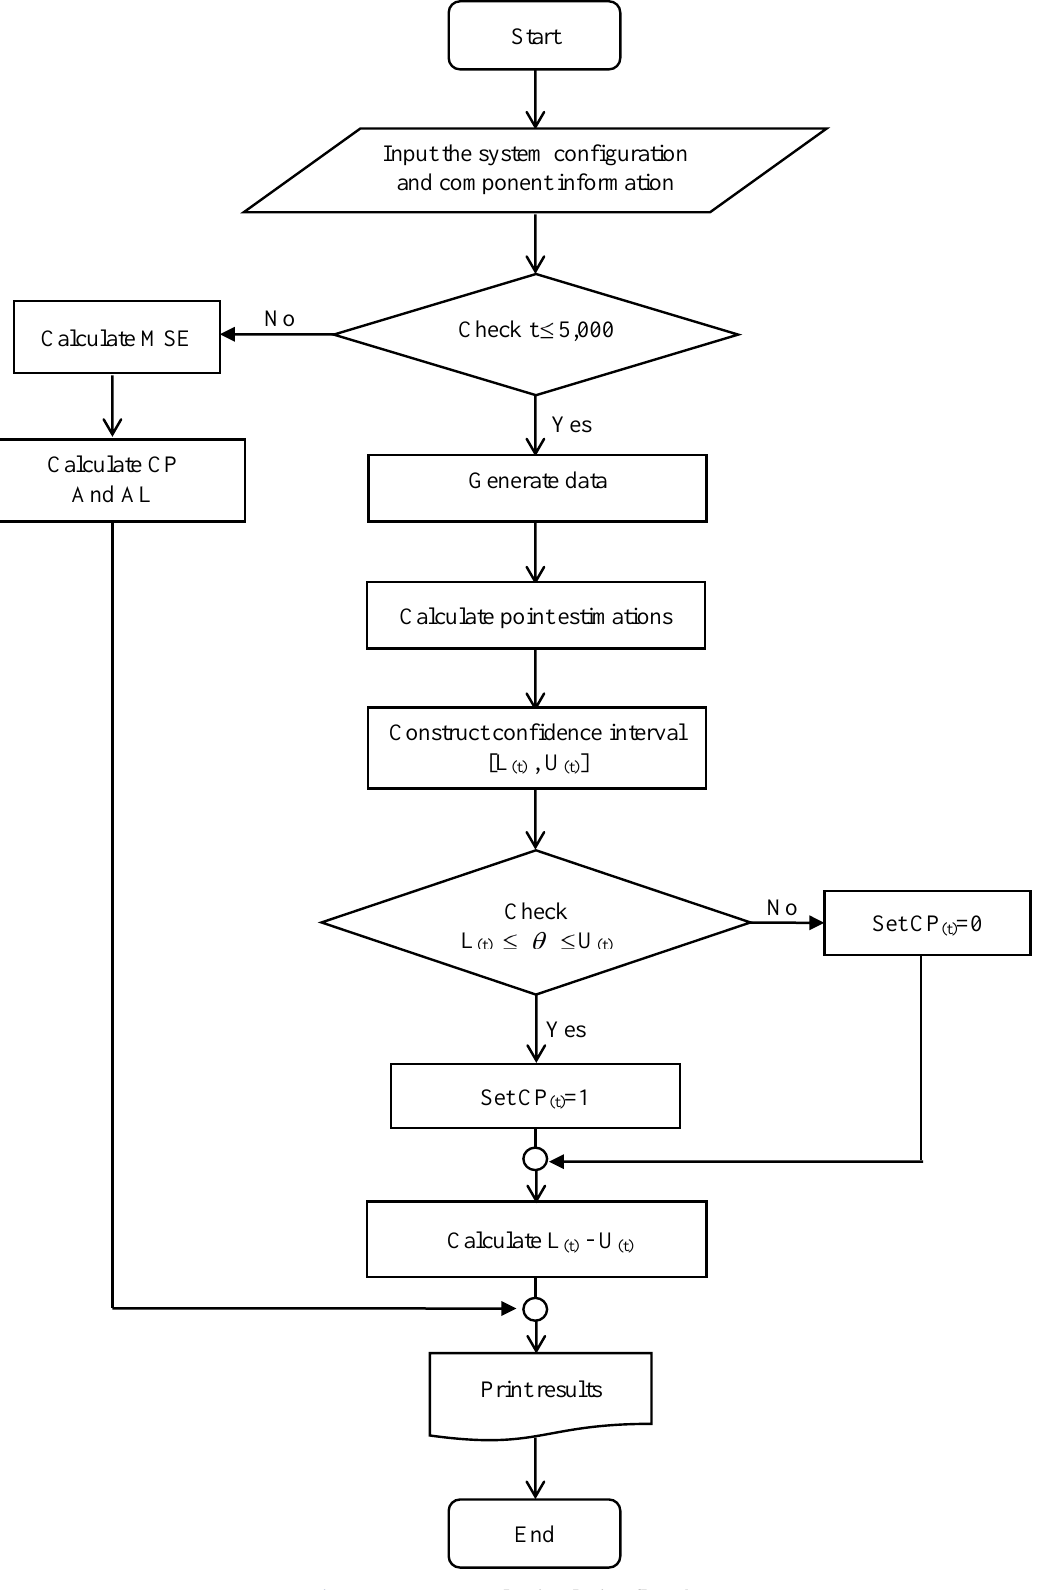
Figure 1. Monte Carlo simulation